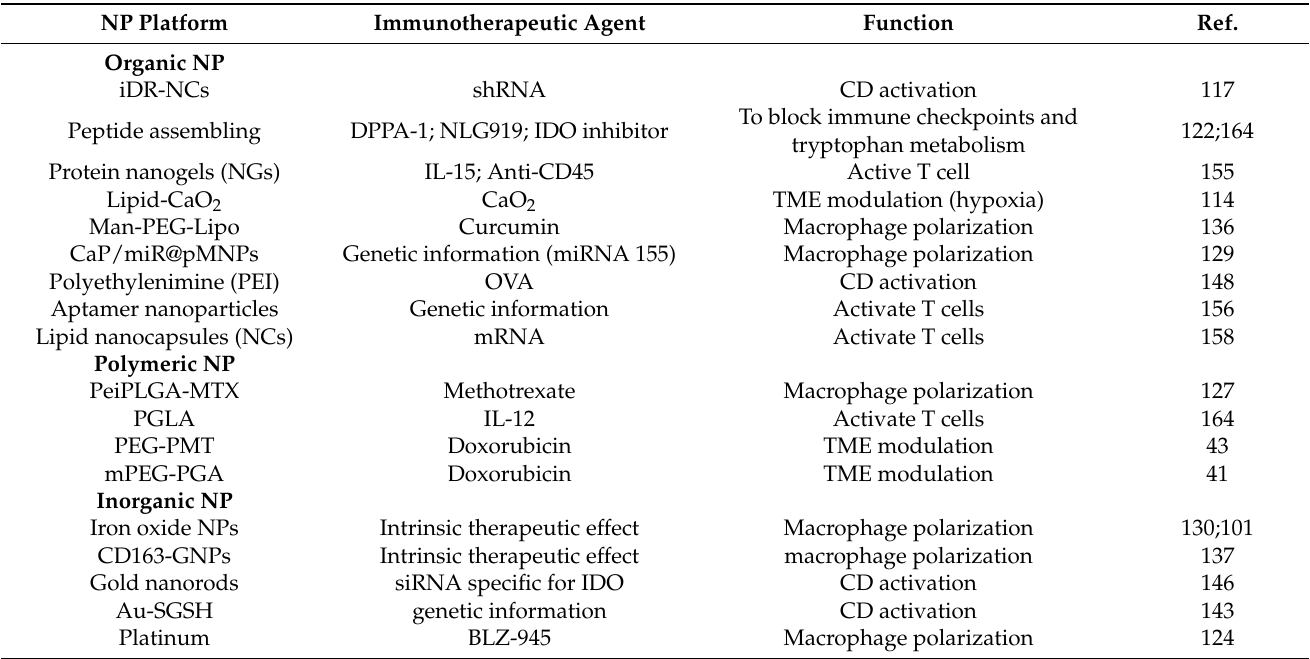
Table 1. Nanocarriers used to modulate the tumor